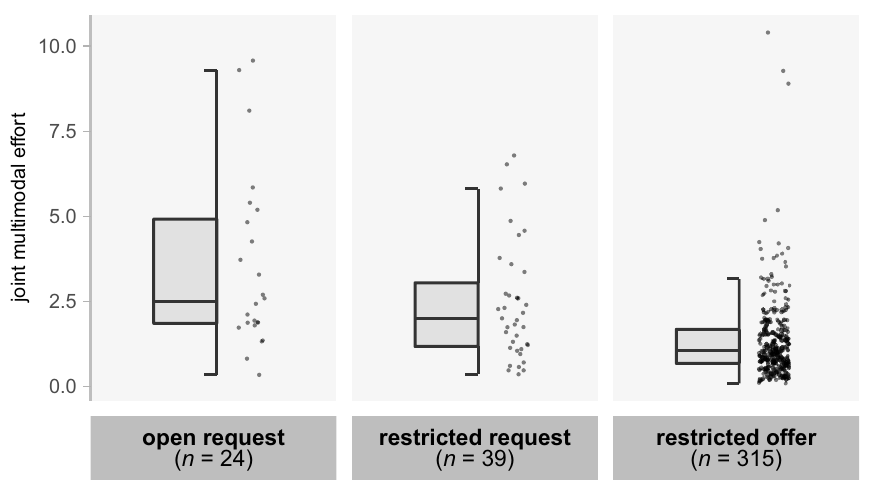
Figure 2. Boxplots showing the joint amount of multimodal effort invested by both participants to resolve the interactional trouble. The boxes represent the interquartile range; the middle line the median; the whiskers the minimum and maximum scores (outliers excluded). Every dot represents a repair sequence, i.e., repair initiation and repair solution together. As the specificity of repair formats goes up, joint multimodal effort invested goes